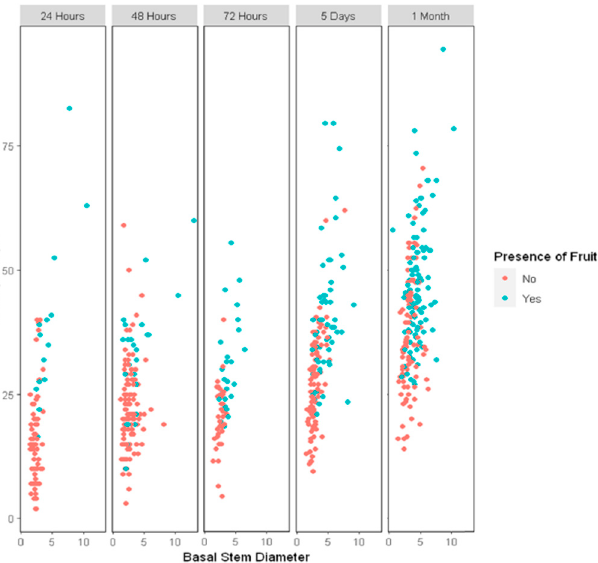
Figure 1. Phenotypic traits evaluated in the field study stage of blueberries ( Vaccinium corymbosum ), showing the variability between height and basal diameters in plants exposed to the same environmental conditions.